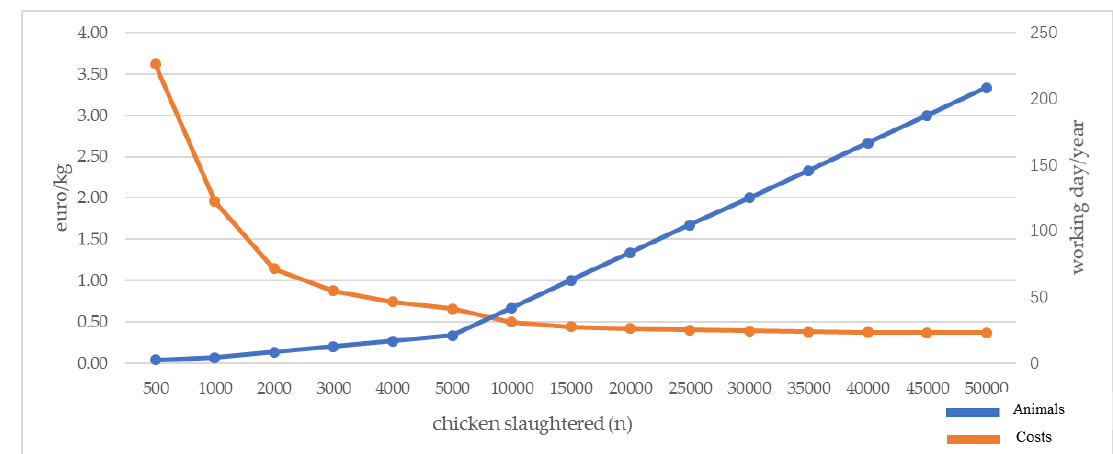
Figure 3. Slaughtering cost ( € /kg) and number of working days according to the number of chickens slaughtered (our